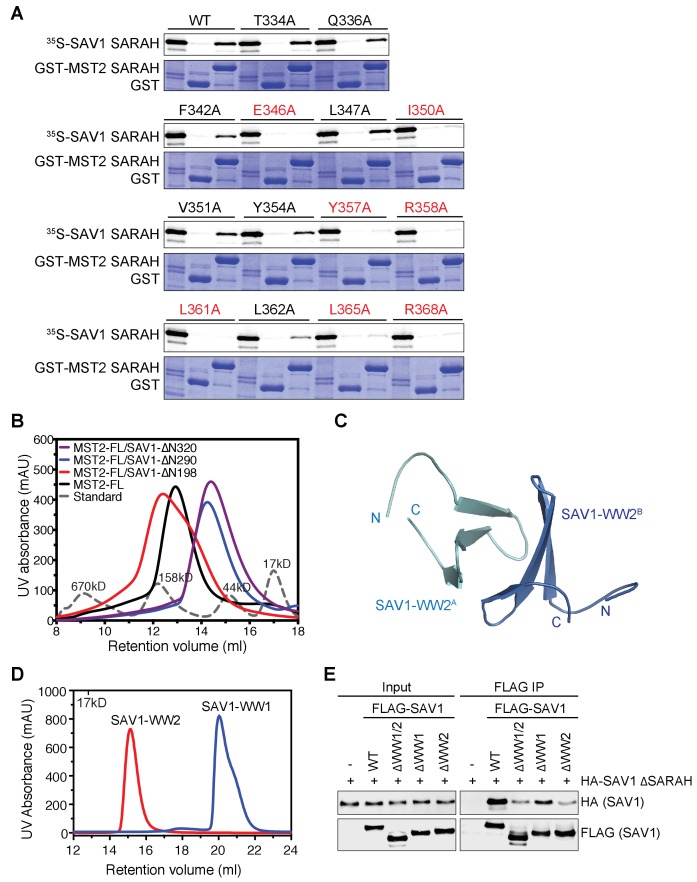
SARAH and WW domains of SAV1 mediate the formation of the MST2-SAV1 heterotetramer.(A) Binding between GST-MST2-SARAH and in vitro translated SAV1 SARAH proteins. SAV1 mutants that are defective in MST2-binding are labeled red. (B) UV traces of molecular weight standards (dashed line), MST2-FL (black line), MST2-FL/SAV1-ΔN320 (purple line), MST2-FL/SAV1-ΔN290 (blue line), and MST2-FL/SAV1-ΔN198 (red line) fractionated on a Superdex 200 gel filtration column. (C) Cartoon drawing of the solution structure of the mouse SAV1 WW2 homodimer (PDB ID: 2DWV) (Ohnishi et al., 2007). Monomer A is colored cyan and monomer B is colored blue. (D) UV traces of human SAV1 WW1 (blue line), and WW2 (red line) fractionated on a Superdex 75 gel filtration column. The molecular weight standard is indicated. (E) Anti-HA and anti-FLAG blots of cell lysates (input) and anti-FLAG IP of 293FT cells co-transfected with HA-SAV1 ∆SARAH and the indicated FLAG-SAV1 plasmids.